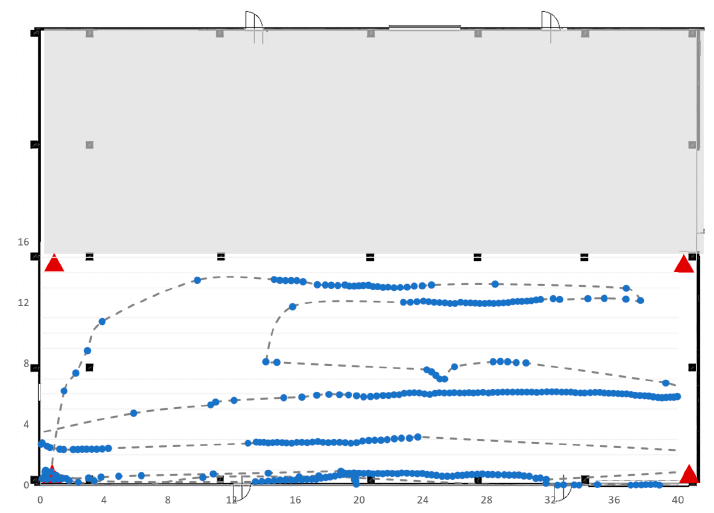
Figure 21. Trajectory followed by the tag in Test